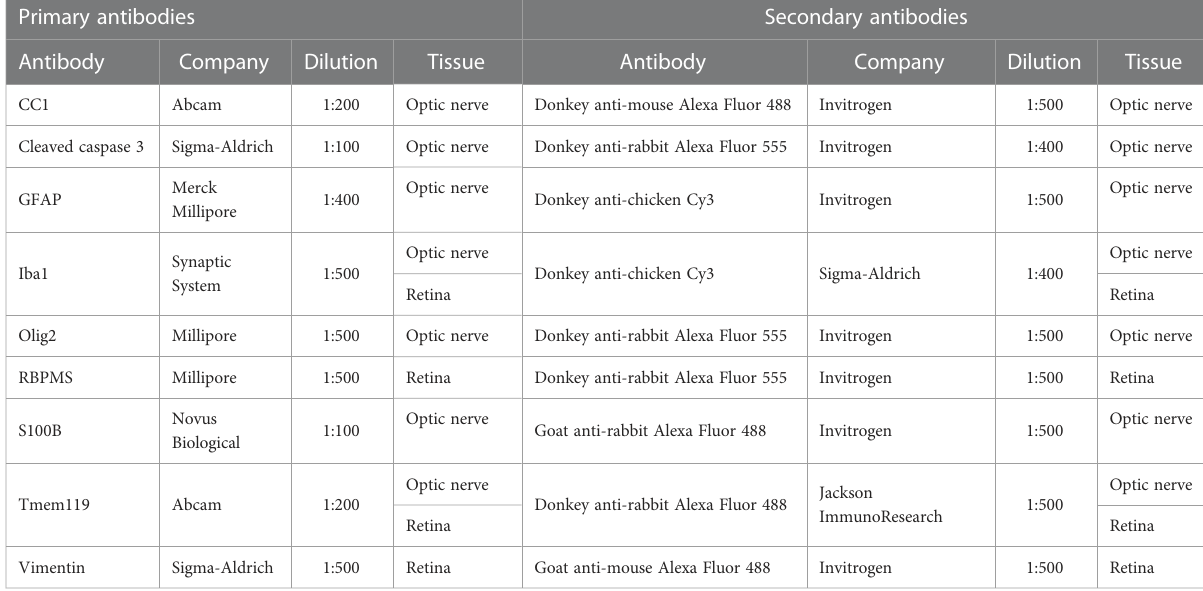
TABLE 2 Primary and secondary antibodies used for immunohistology on optic nerve and retina sections. Primary antibodies